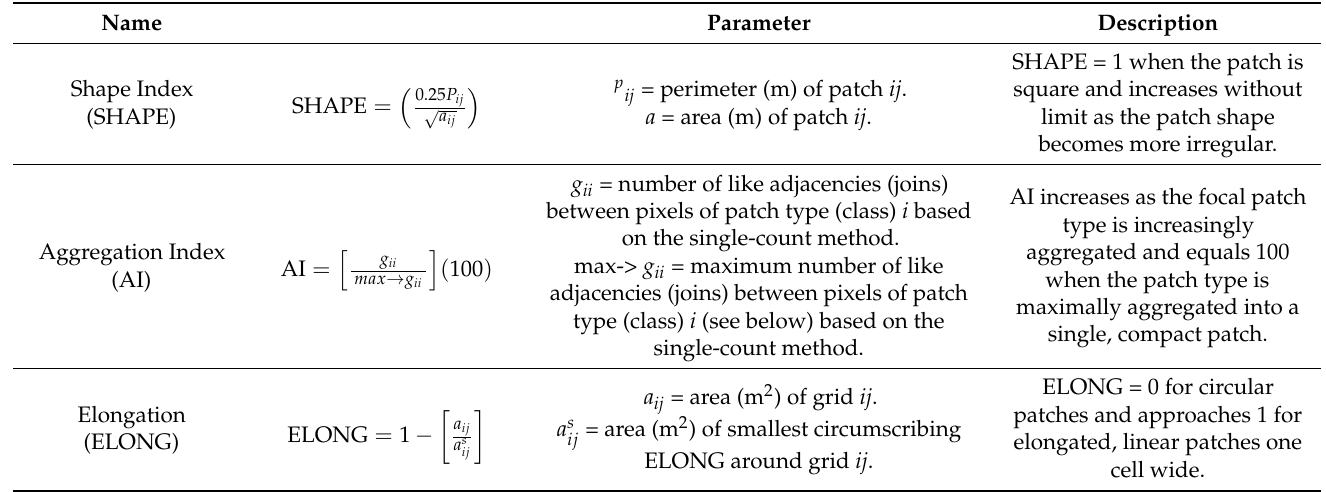
Table 2. Computational method and description of geometric urban form